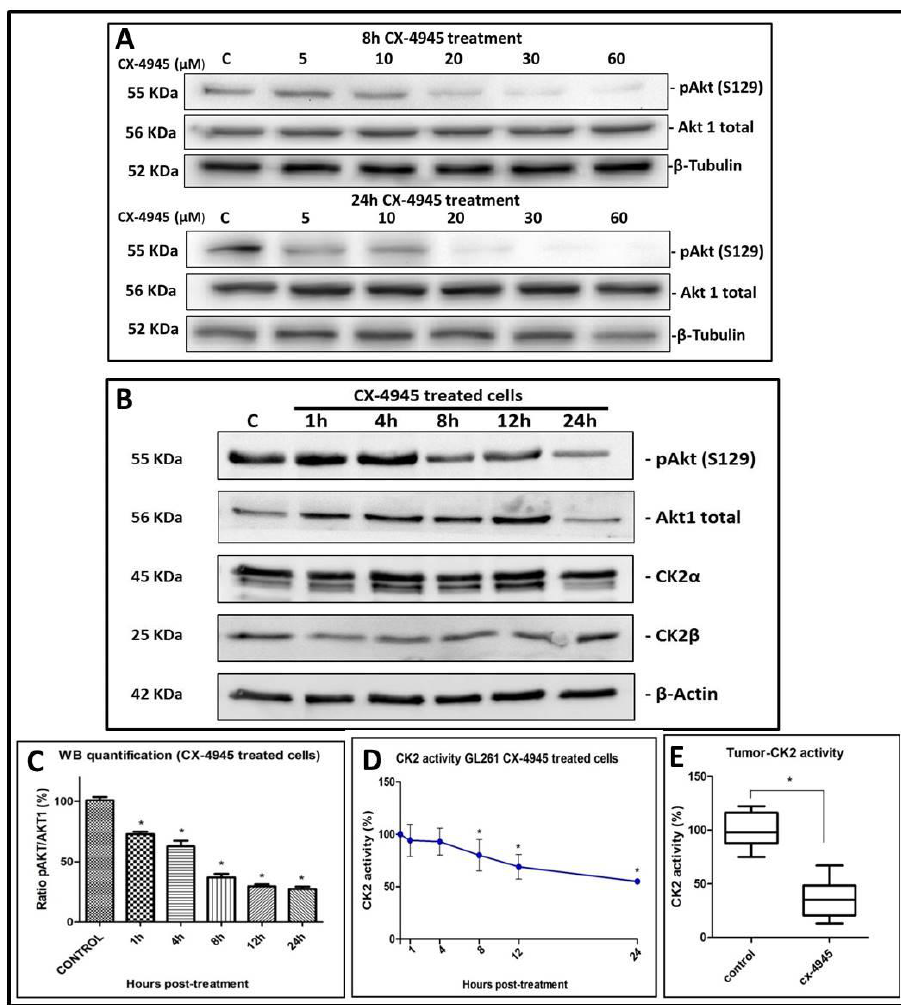
Figure 2. CK2 activity in GL261 cells and tumour samples. ( A ) Western blot for GL261 cell protein extracts (25 µ g) treated with increasing doses of CX-4945 (from left to right: control (C) and CX-4945 treated cells 5 µ M, 10 µ M, 20 µ M, 30 µ M and 60 µ M). This experiment was performed with n = 1 for each condition and for 8 h (upper part) or 24 h (lower part). p-Akt(S129), Akt1 total and β -Tubulin proteins were analysed; ( B ) Western blot for GL261 cell protein extracts (25 µ g) treated with 67.2 µ M CX-4945 (from left to right: control (C) and CX-4945 treated cells for 1 h, 4 h, 8 h, 12 h and 24 h). The experiment was performed with n = 3 for each condition. p-Akt(S129), Akt1 total, CK2 α , CK2 β and β -Actin proteins were analysed; ( C ) Quantification of western blot (WB) for GL261 cell protein extracts (25 µ g) treated with CX-4945 ( n = 3 per each condition). Ratio (%) of p-Akt(S129) content divided by Akt1 total content, while the control values (C) for this ratio are taken as the 100% start value. * = p < 0.05 for Student’s t -test for the comparison of control and treated groups; ( D ) CK2 activity measured on a CK2-specific synthetic peptide in lysates from GL261 cells treated with 67.2 µ M CX-4945